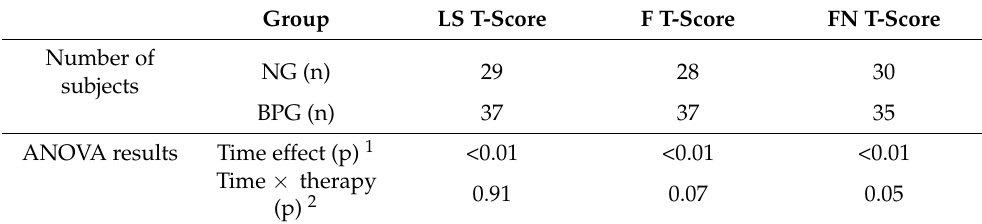
Table 4. BMD comparison between NG and BPG